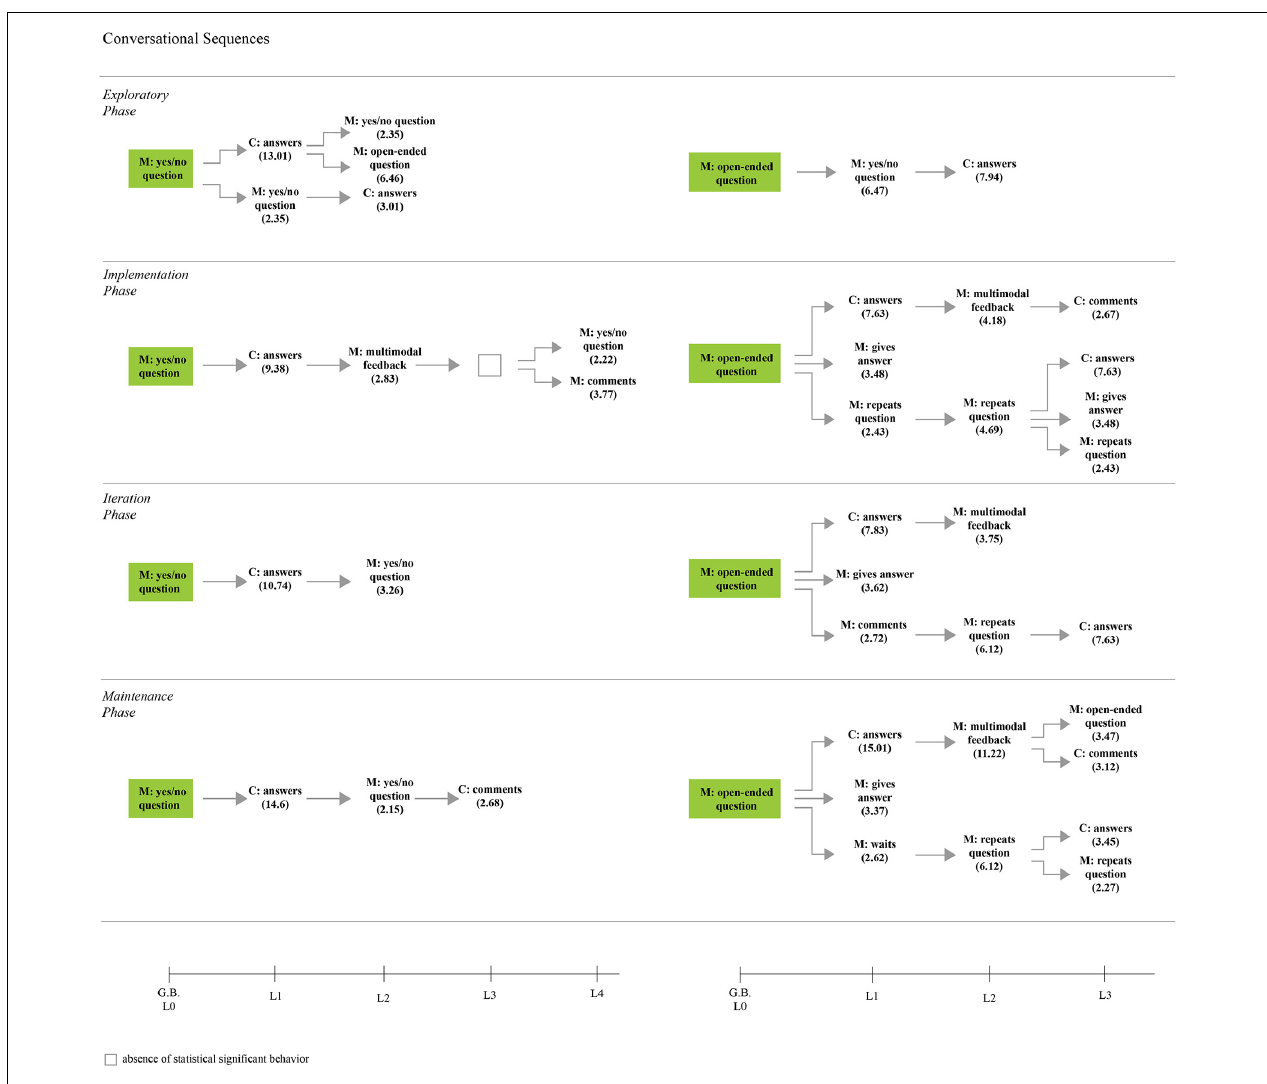
FIGURE 6 | Sequential communicative patterns obtain in each phase during the storybook reading with the mother’s closed-ended and open-ended emotion-related questions as given behavior [M, Mother; C,